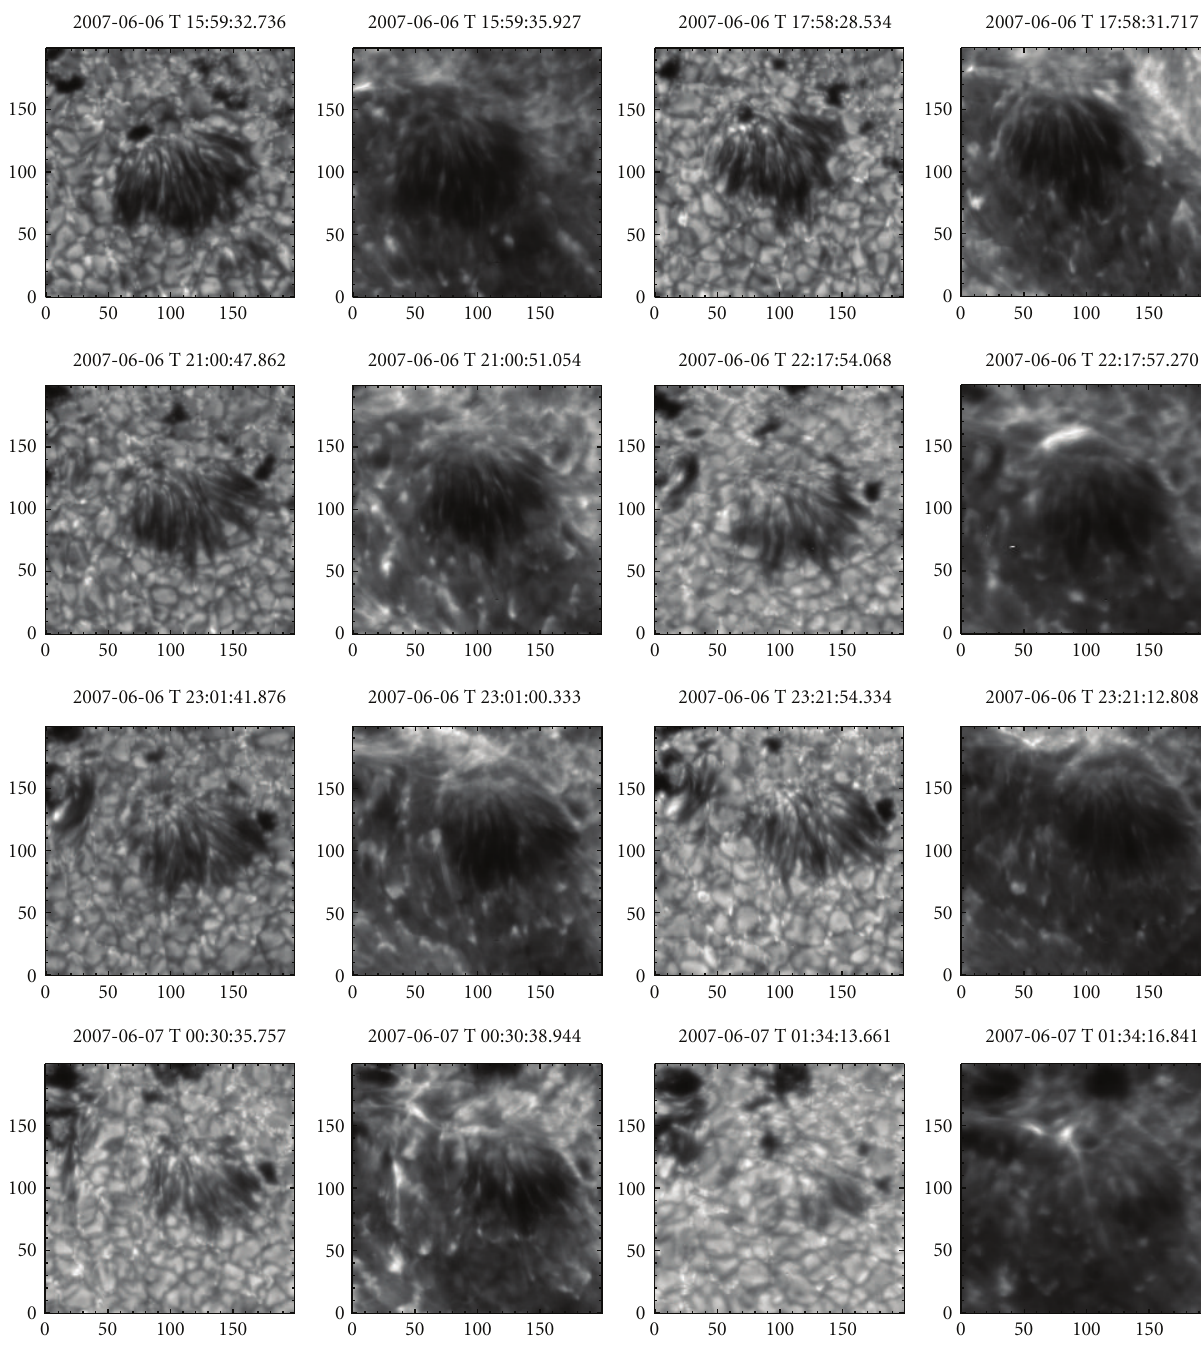
Figure 3: The temporal evolution of the PLFs is shown in sequence of G-band and Ca II H images alternatively. The date and time of the image acquisition is shown on the top of each image. The numbers on the axes represent the pixel.